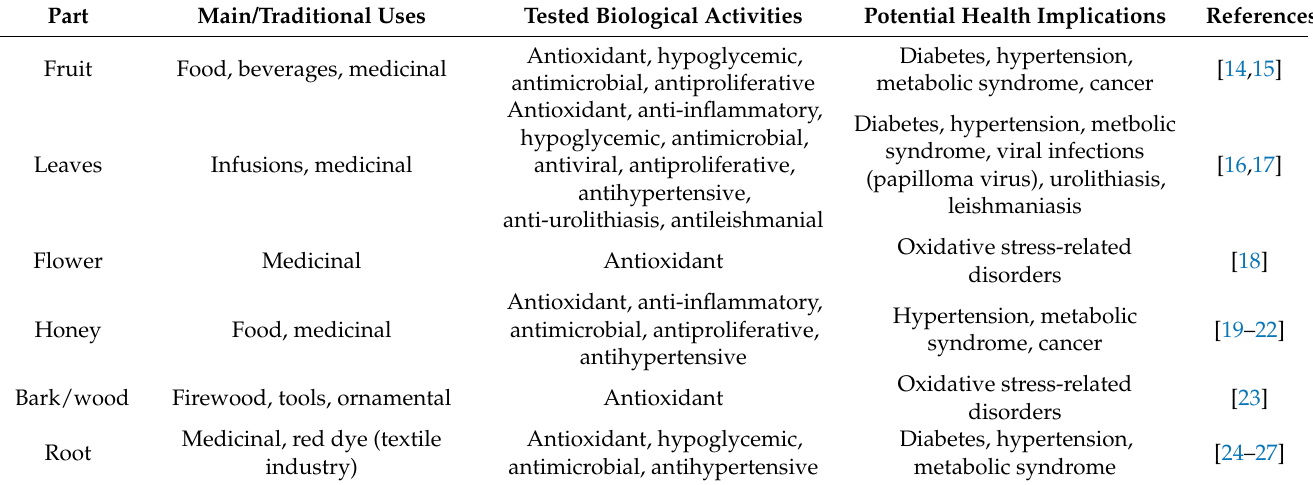
Table 2. Traditional uses, biological activities and potential health implications (related disorders whose risk may be reduced) of the main parts of Arbutus unedo